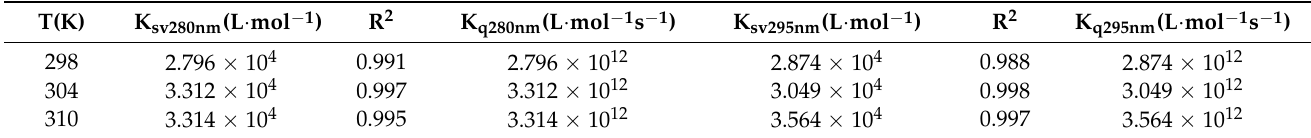
Table 1. The Stern–Volmer quenching constants of EGCG compounded to PPI.